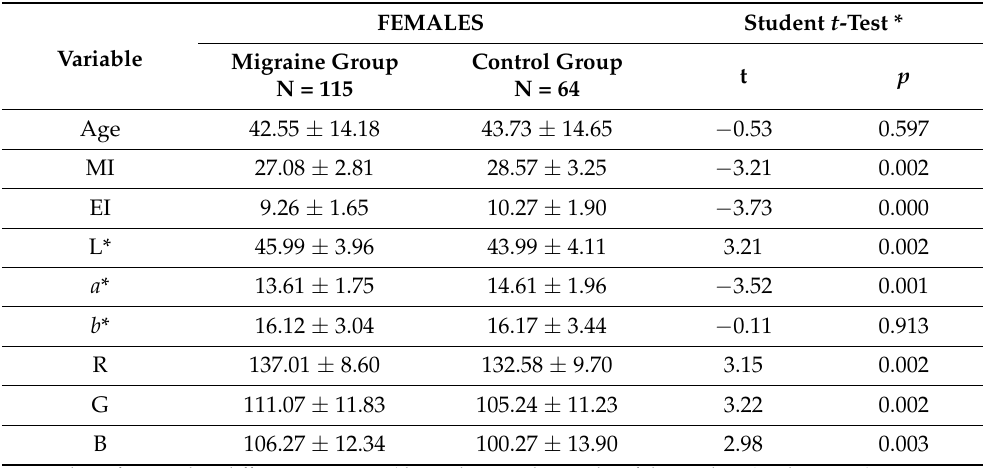
Table 1. Statistical characteristics ( in females.